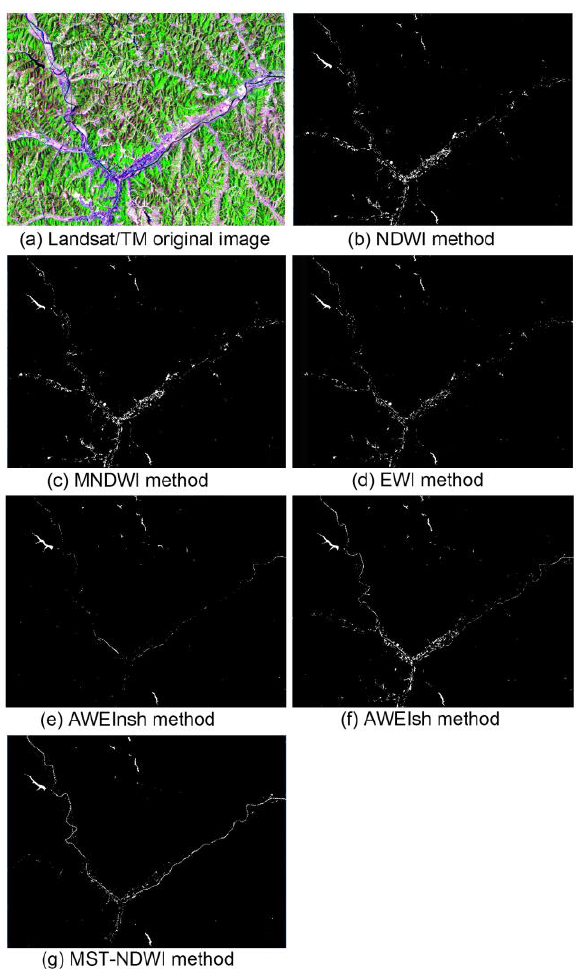
Figure 11. Comparison of Landsat/TM image (a) and MST-NDWI (g) in the lower reaches of Yanhe